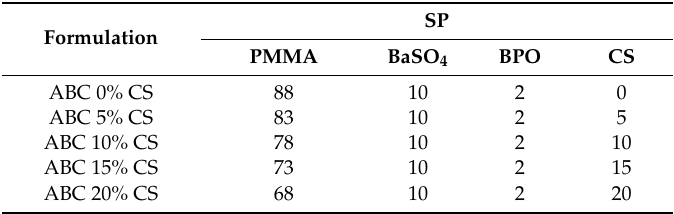
Table 1. Composition percentage (wt.%) of the solid phase (SP) of the acrylic bone cements (ABCs)